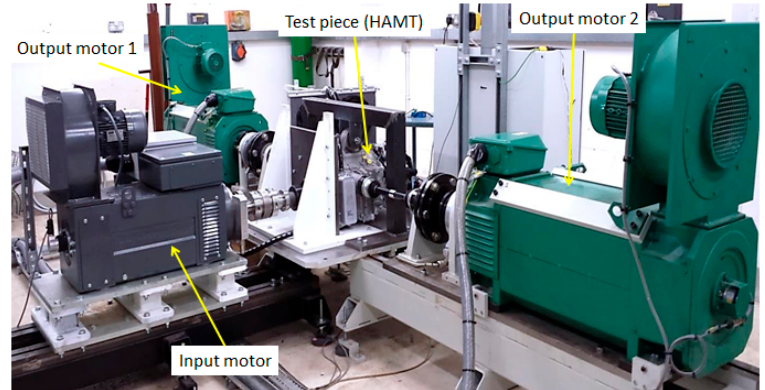
Figure 8. The University of Surrey transmission test rig.